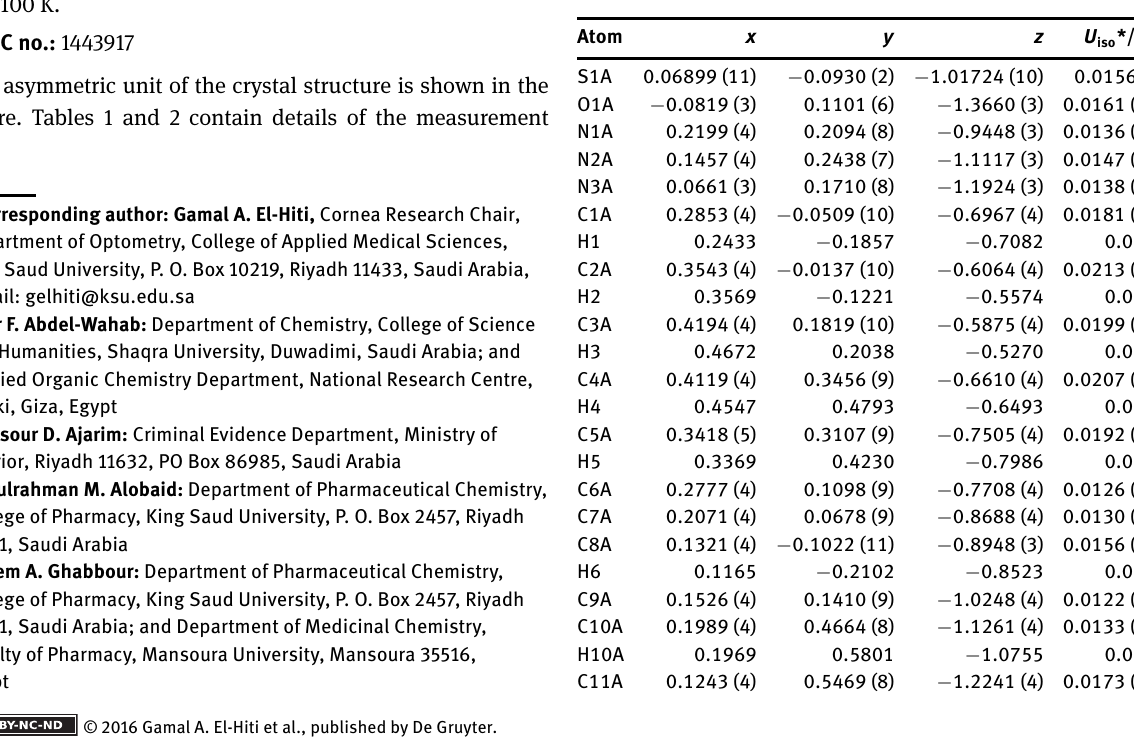
Table 2: Fractional atomic coordinates and isotropic or